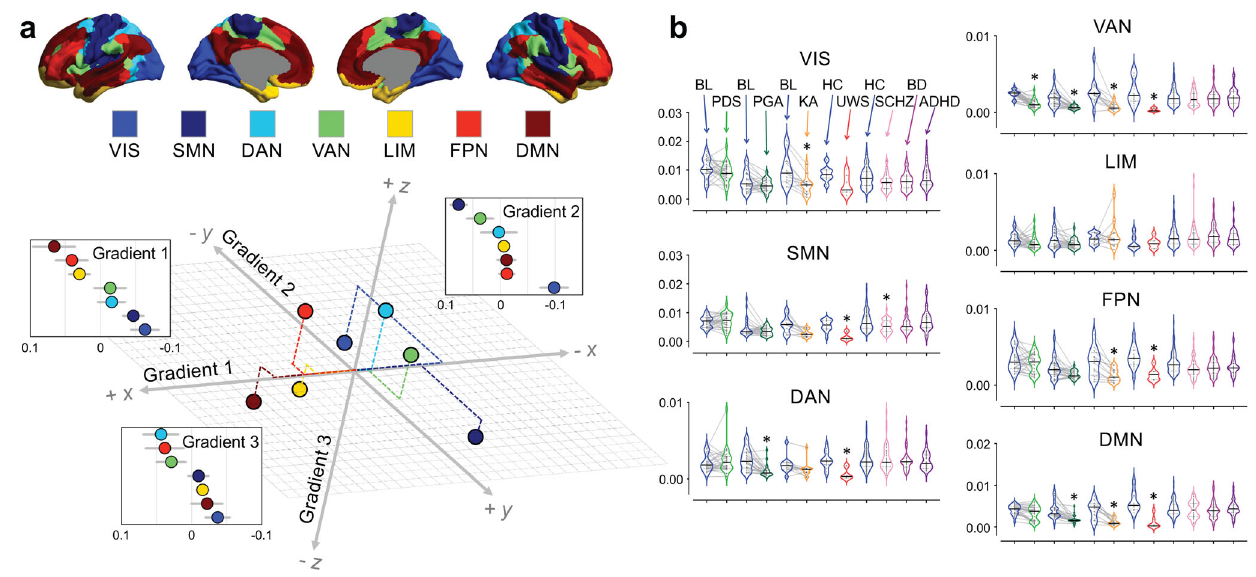
Fig. 4 | Network eccentricity in various states of consciousness. a Seven pre- de fi ned functional networks include the visual network (VIS), somatomotor net- work (SMN), dorsal attention network (DAN), ventral attention/salience network (VAN), limbic network (LIM), frontoparietal network (FPN), and default-mode net- work (DMN). Schematic illustration of network position in a 3D gradient space. Diffusion map embedding was applied to the group-averaged functional con- nectivity matrix in conscious baseline and healthy controls ( n =193; pooled across all datasets). Gradient eigenvector loading values (mean±SD across areas within a given network) are shown for each network. Dashed lines indicated the relative distance from global centroid to each network ’ s centroid along each axis. b Violin plots(median:solidline;quantiles:dashline)ofnetworkeccentricity,measuredby